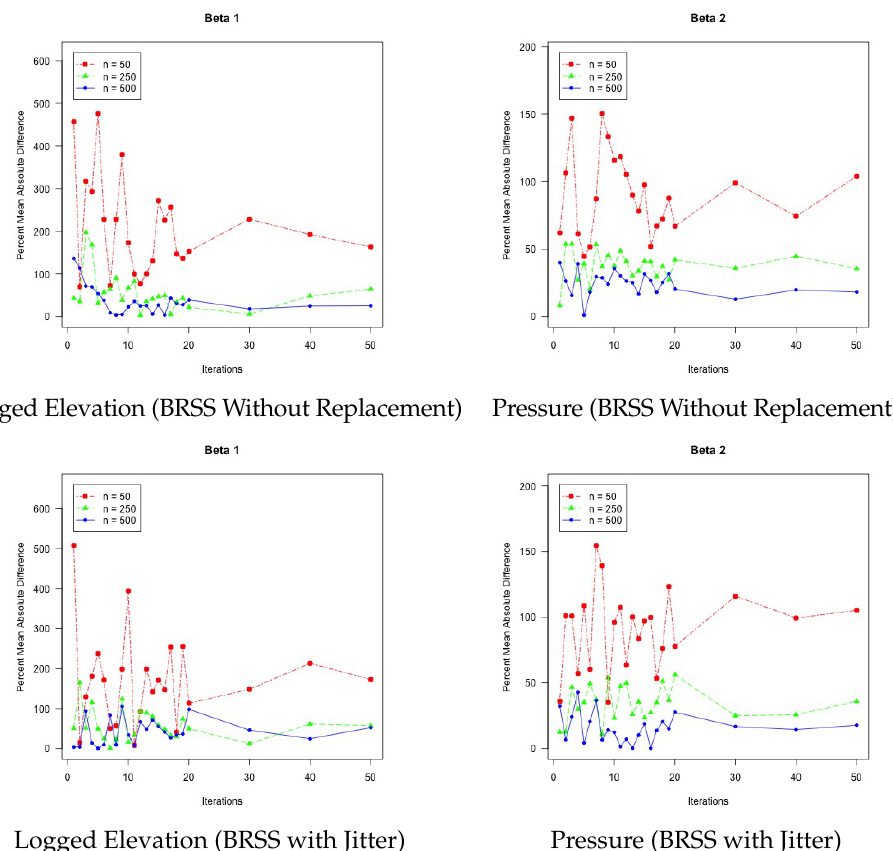
Figure 4. A Comparison of the BRSS Without Replacement and BRSS with Jitter